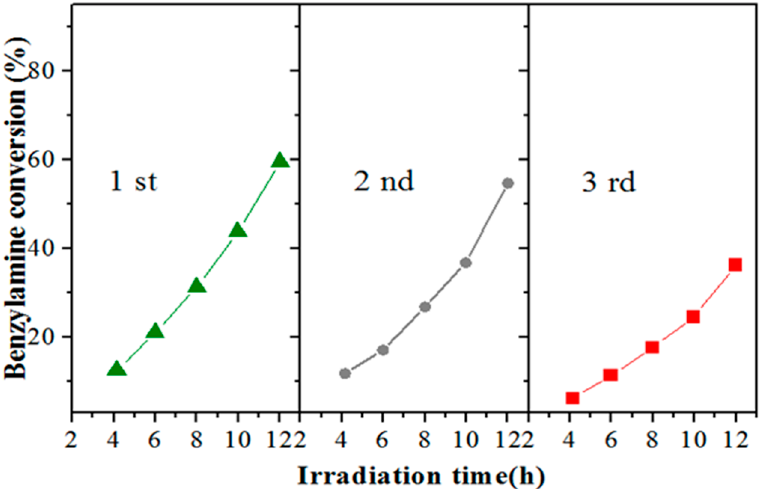
= 0.7 Mo 0.3 O 4 (x